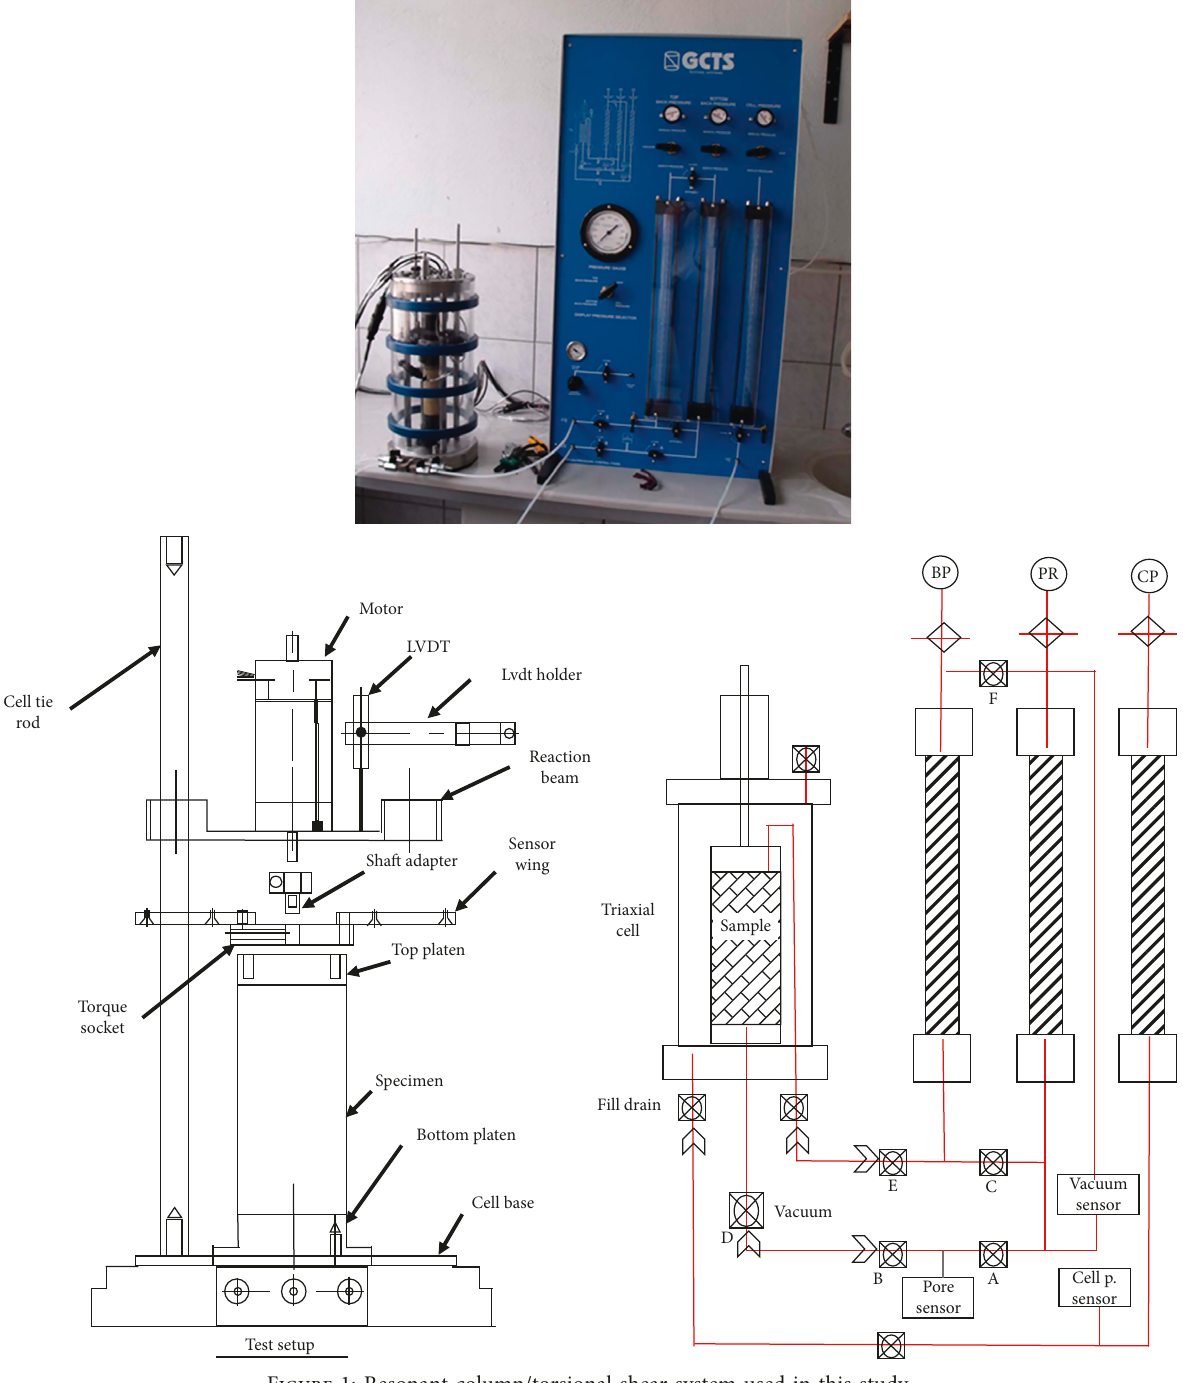
Figure 1: Resonant column/torsional shear system used in this